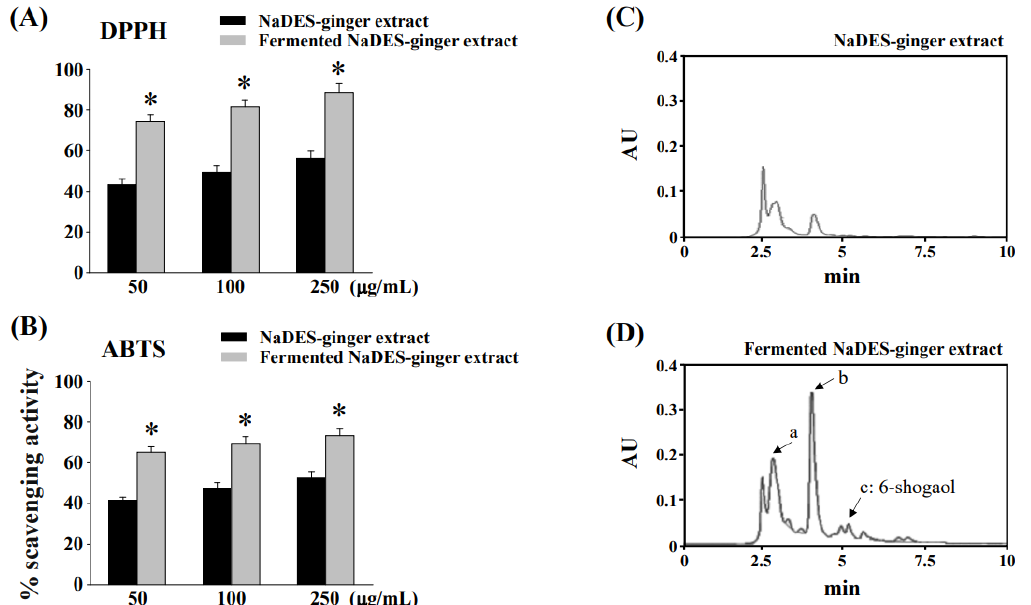
Figure 1. Changes in chemical compositions and antioxidant activity of the ginger extract in NaDES after fermentation. ( A ) DPPH radical scavenging activity and ( B ) ABTS radical scavenging activity of non-fermented NaDES-ginger extract and fermented NaDES-ginger extract. Bars represent the standard deviation from triplicate determination of each concentration. * p < 0.05 vs. non-fermented NaDES-ginger extract. HPLC profiles of ( C ) non-fermented NaDES-ginger extract and ( D ) fermented NaDES-ginger extract showing the main peaks increased (peaks a, b, and c) in fermented NaDES-ginger extract.